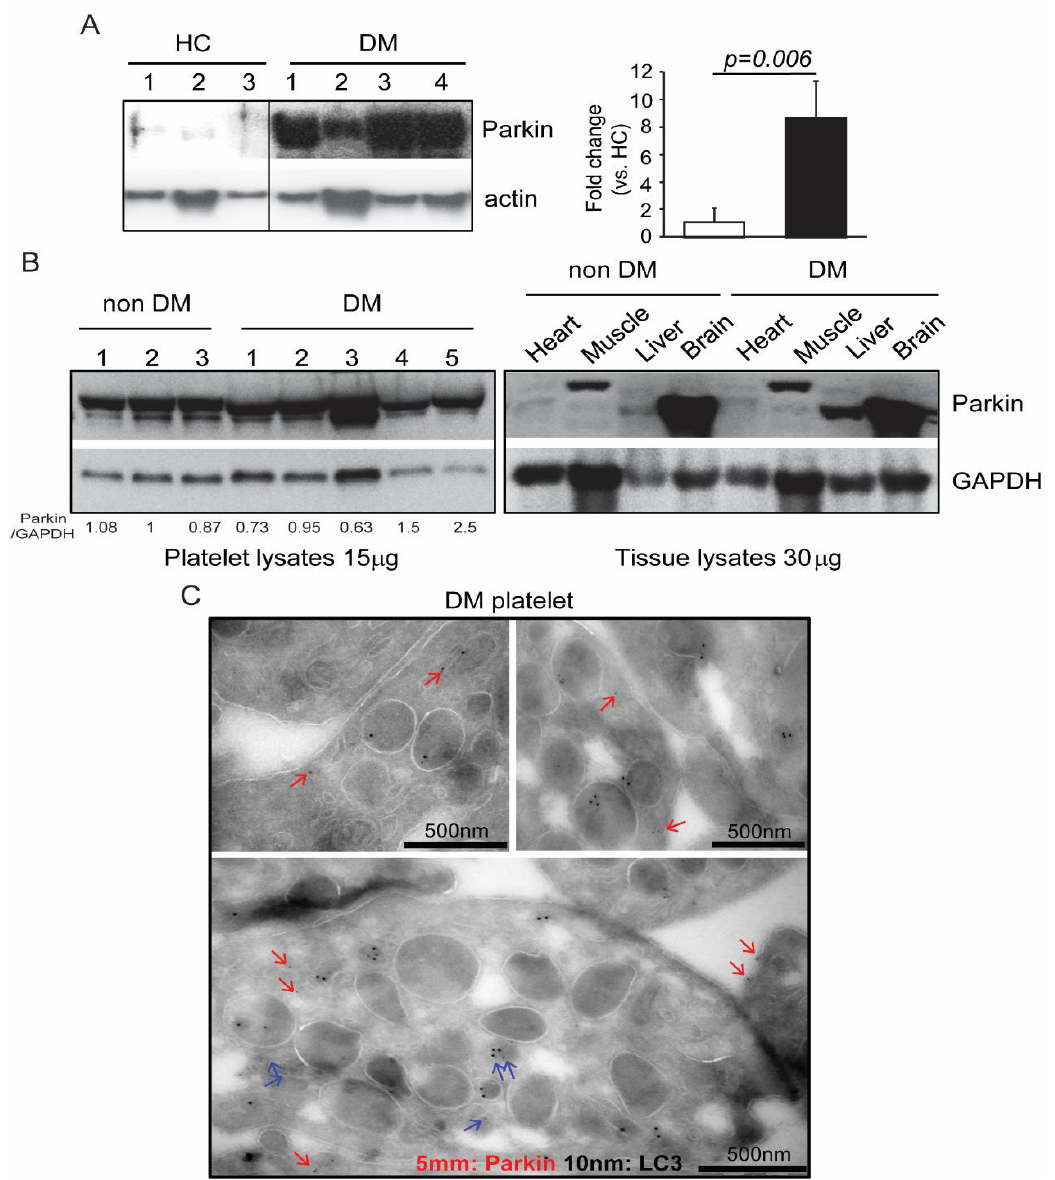
Figure 1. Parkin was highly expressed in platelets. ( A ) Western blot analysis of Parkin expression in human platelets (platelets isolated from three healthy control and four diabetic patients) (left). Quantification of Parkin in HC and DM (right) ( B ) Platelets, heart, muscle, liver, and brain tissues isolated from non-DM and DM mice (platelets isolated from three non-DM and five DM mice). Western blot analysis of Parkin in each sample with lanes representing individual mice. ( C ) Parkin and LC3 immuno-EM analysis of DM platelets where 5 nm dots indicate immunogold-labeled Parkin clusters, and 10 nm dots indicate immunogold-labeled LC3 clusters. Representative areas of clusters of gold labeling in DM patients ( A – C ) are presented. Blue arrows indicate mitochondrial and granular Parkin. Red arrows indicate parkin in other regions.